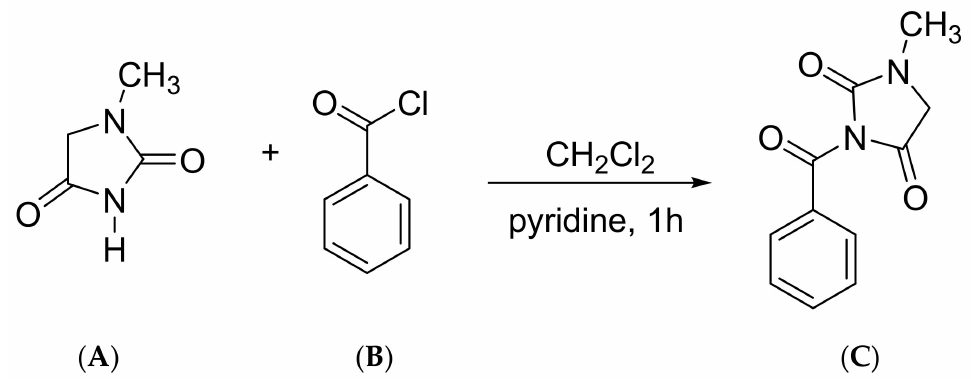
Figure 2. 1-methyl hydantoin pre-column derivatization equation. ( A ) 1-methyl hydantoin; ( B ) benzoyl chloride; ( C )